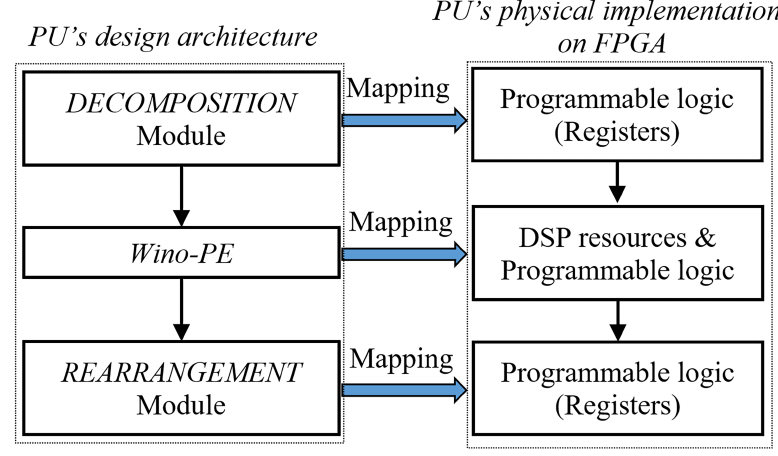
Figure 9. The architecture-to-implementation mapping on FPGA for a